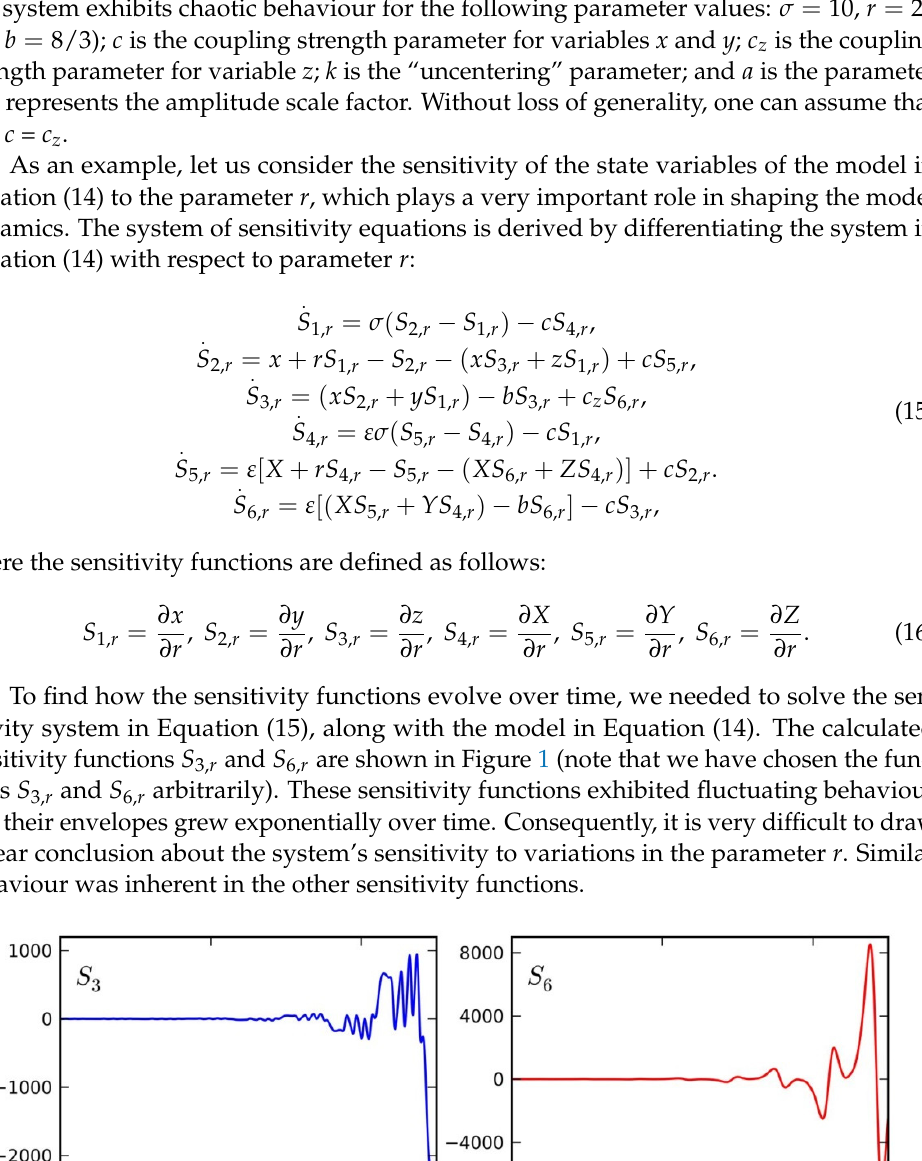
Figure 2. Original (red) and pseudo (blue) trajectories for the fast z and slow Z variables, calculated for strong coupling between fast and slow systems ( 𝑐 = 0.8 ). Table 1. Sensitivity functions for fast and slow variables for strong ( 𝑐 = 0.8 ) and weak ( 𝑐 = 0.15) coupling between systems. c